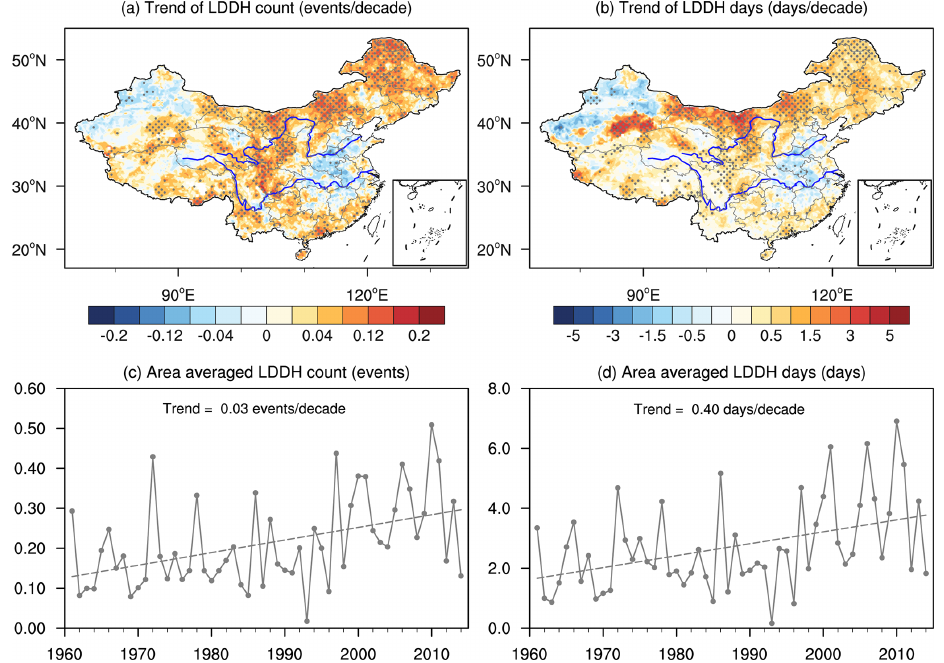
Figure 3. Trends in the seasonal number of grid-scale (a) LDDH events and (b) LDDH days over the period 1961–2014. Stippling denotes statistically significant trends at the 90% confidence level. Regionally averaged time series of annual mean LDDH event (c) count and (d) total days. The dashed line shows the linear